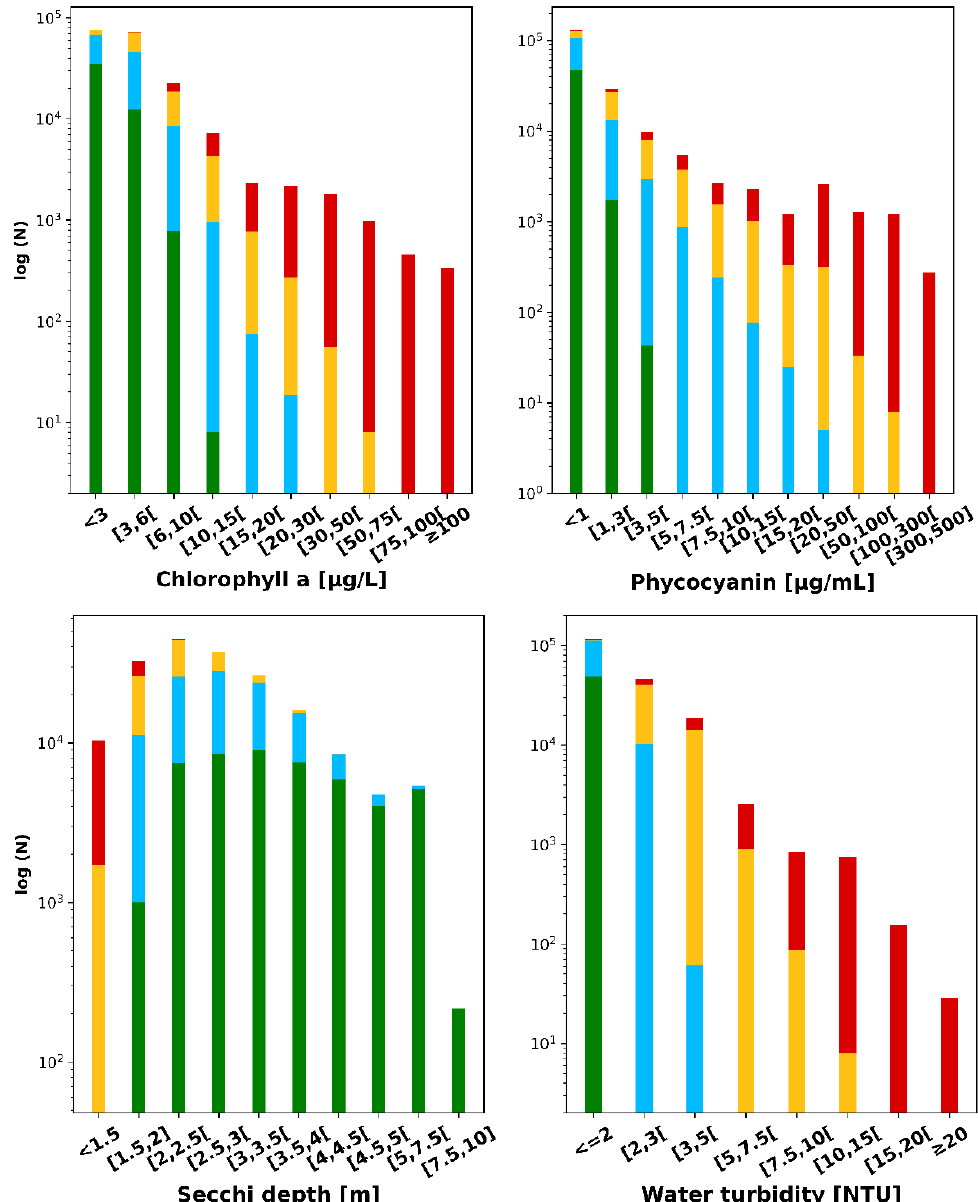
Figure 11. Number of pixels per OWT cluster and for each of the classes of water quality parameters. The figures above represent Chl-a concentrations ( left ) and PC concentrations ( right ). Below represent SD ( left ) and Turb ( right ). The green bars represent OWT1, in blue OWT2, in orange OWT3, and red is OWT4.